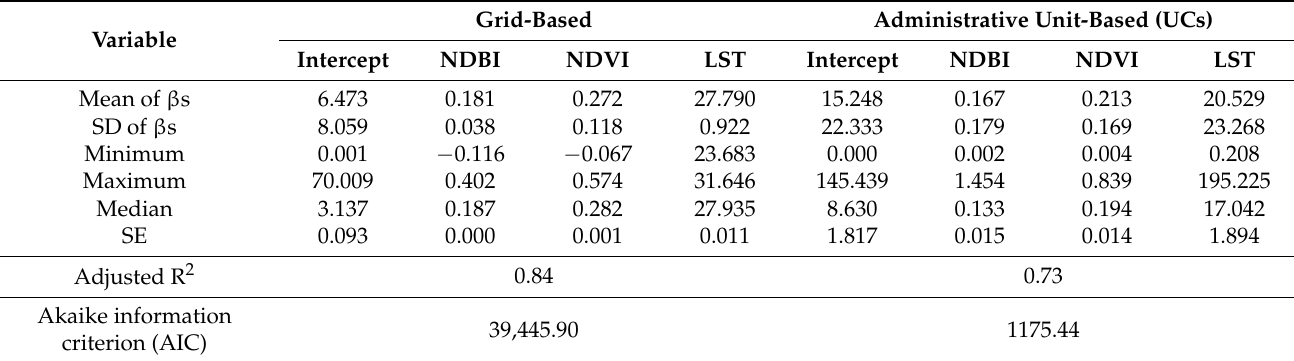
Table 3. Results from the GWR model for grid-based and administrative unit-based analysis.